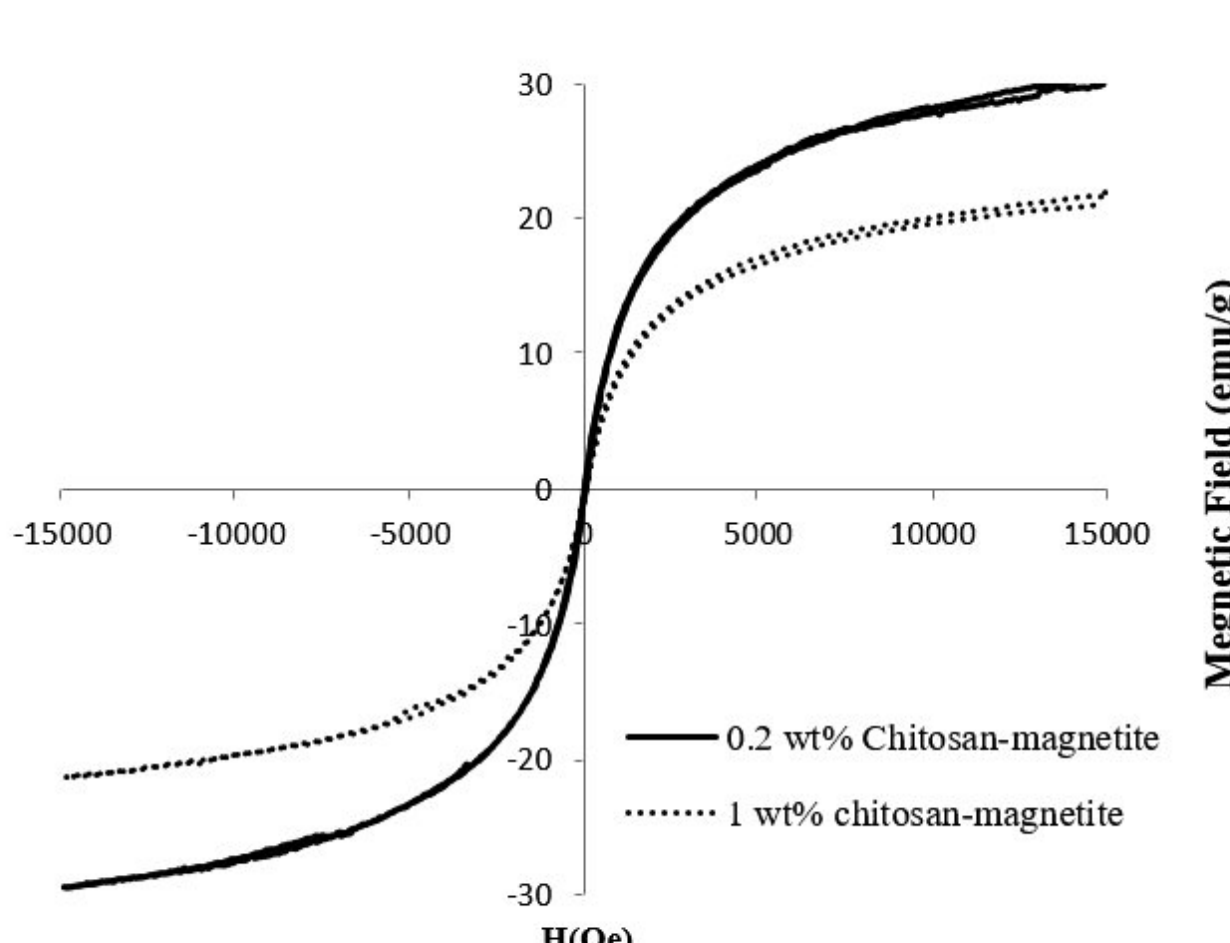
FIGURE 5 - VSM data for chitosan-magnetite nanobeads where the magnetite concentration is 3.9 mg/mL Magnetite nanoparticles that are incorporated into the nanobeads exhibit superparamagnetic properties and possess lower saturation magnetizations as expected due to non-magnetic layer around the